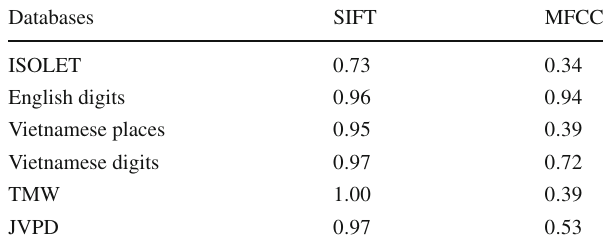
Table 1 Compare average c orrect classification rate of LNBNN with MFCC and SIFT features on six databases